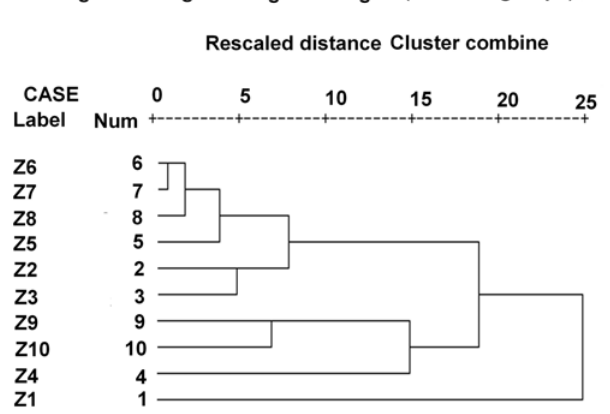
Figure 2. Dendrogram for normalized data set of zonal P. vivax deaths.